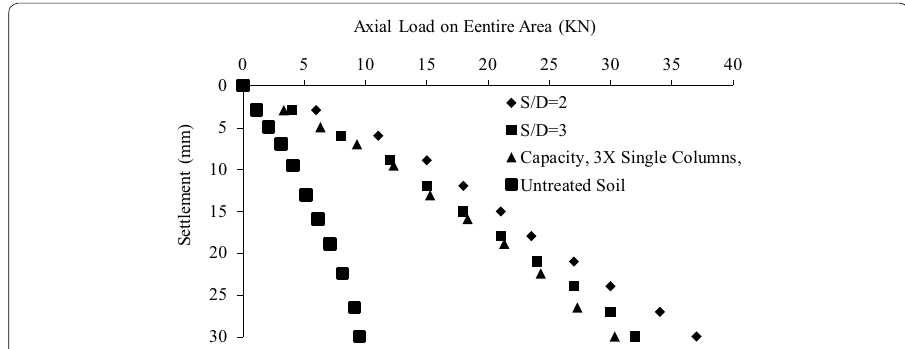
Fig. 8 Effect of group columns on clayey soil at 32 kPa shear strength